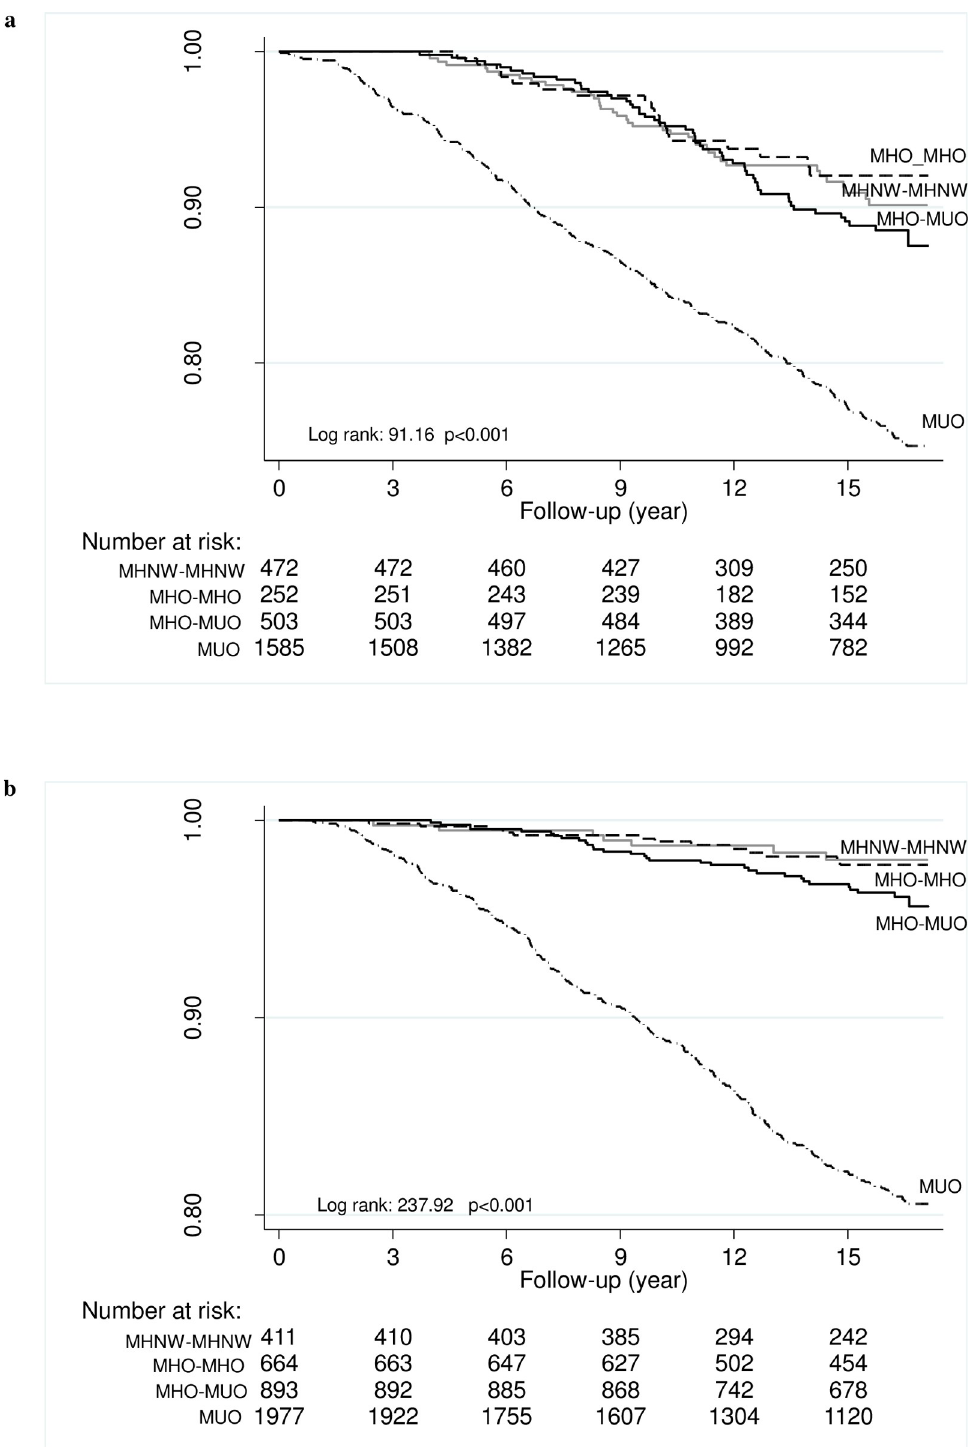
Fig 2. Kaplan-Meier curves for cumulative survival free from cardiovascular events as a function of obesity phenotypes according to body mass index and metabolic health in each obesity phenotype. A -Male, B -Female.